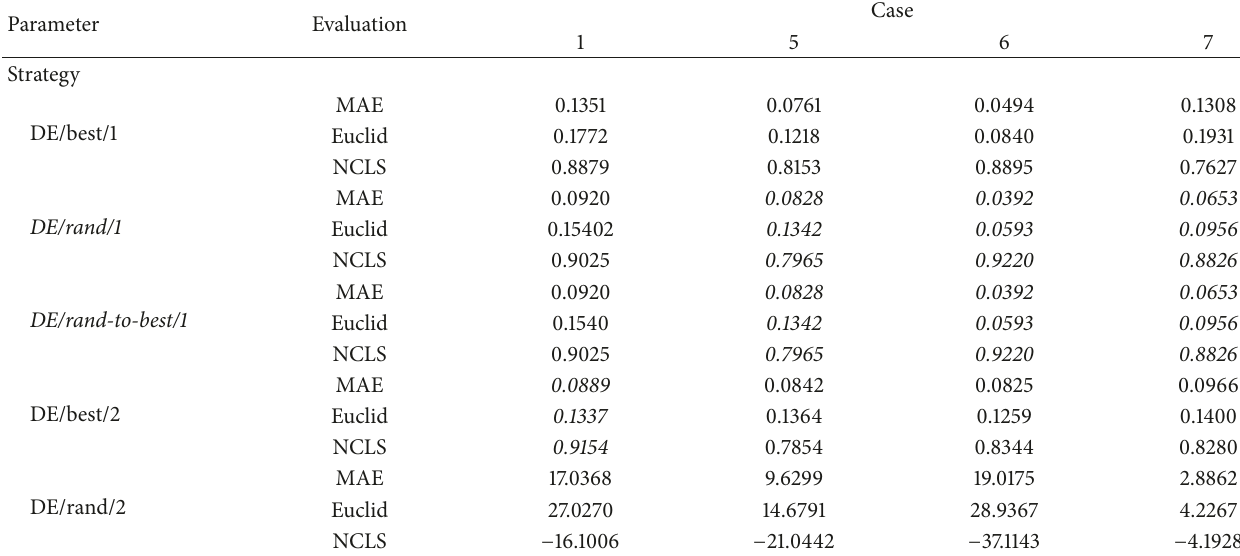
Table 6: Results on parameters of DE.